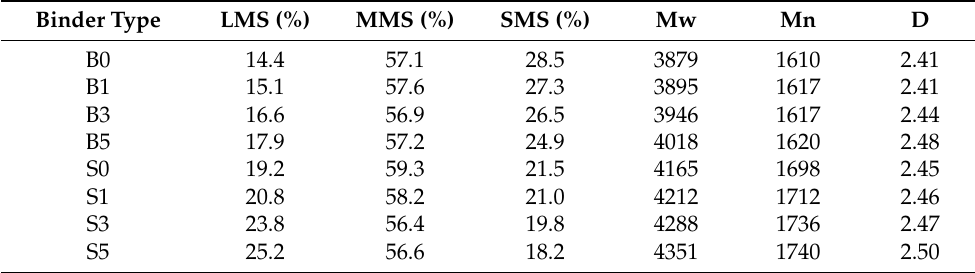
Table 8. Test results of gel